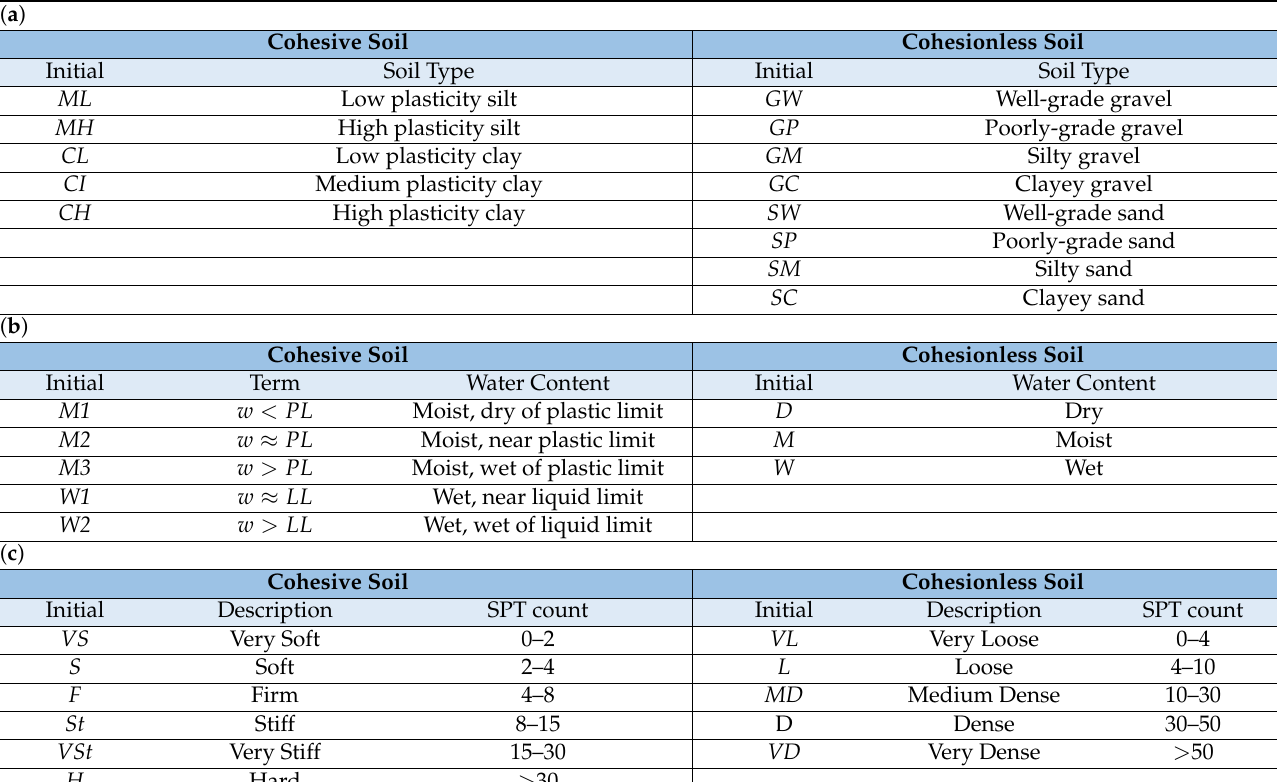
Table 7. Explanation of soil terminologies: ( a ) initials for soil type; ( b ) initials for water content; ( c ) soil descriptions and correlation to SPT count.